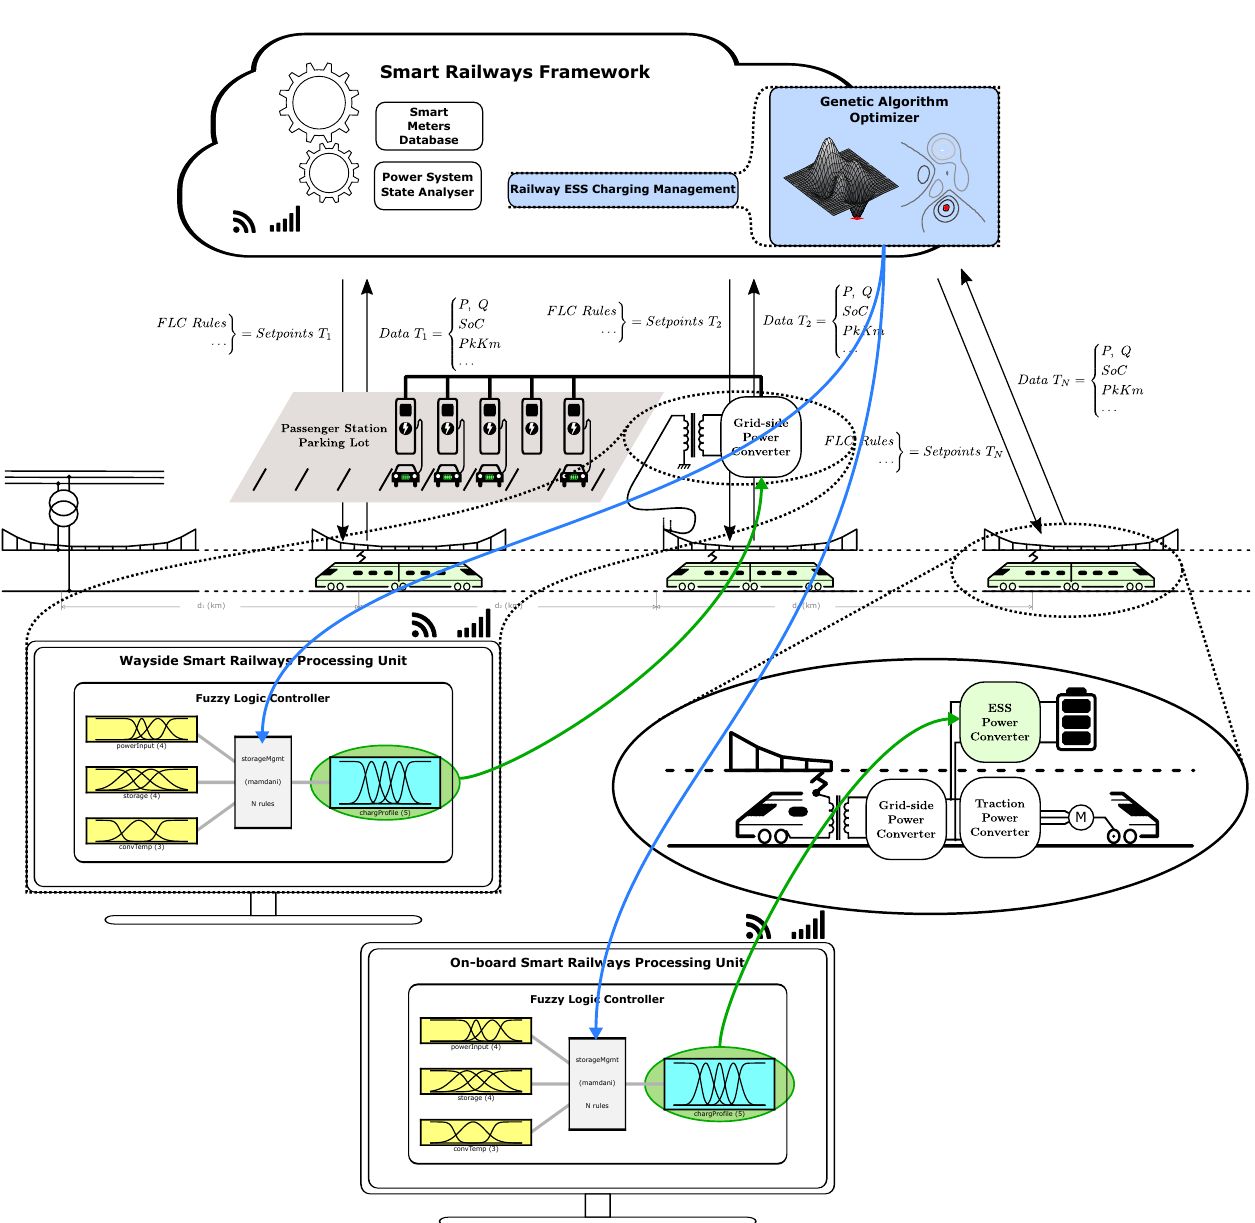
Figure 18. Smart railways framework to support the wayside and on-board railway charging